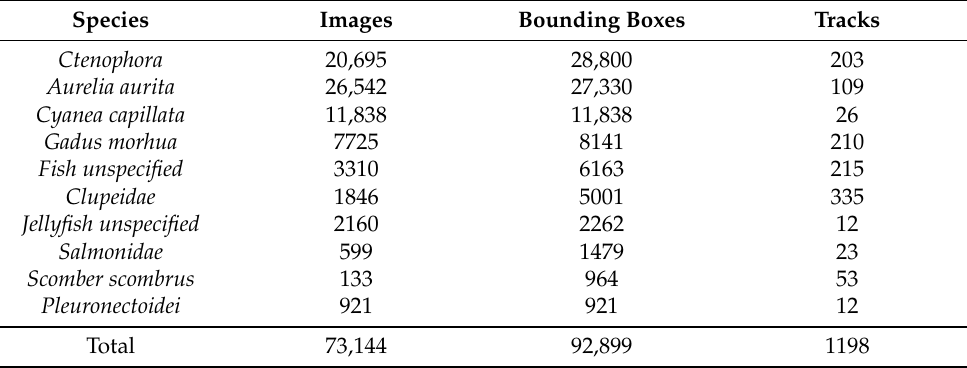
Table 1. The amount of annotated images, bounding boxes and tracks for each object class as included in the used